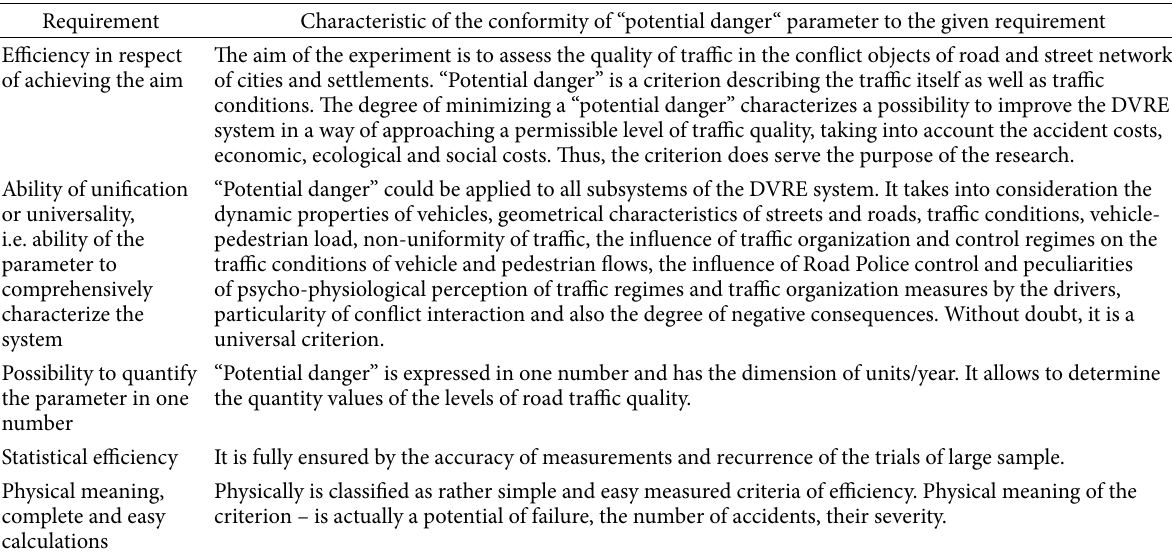
Table 1. Requirements for optimization parameter Requirement Efficiency in respect of achieving the